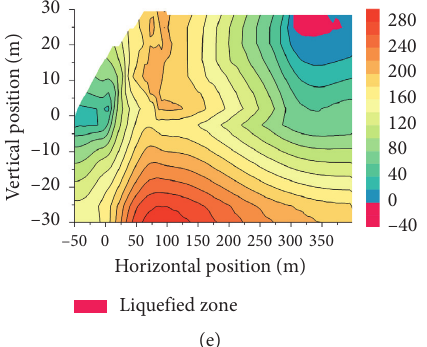
Figure 11: Contour of effective stress in the ash storage field and the liquefied zone. (a) L (d) L d � 150m, (e) L d � 200m.